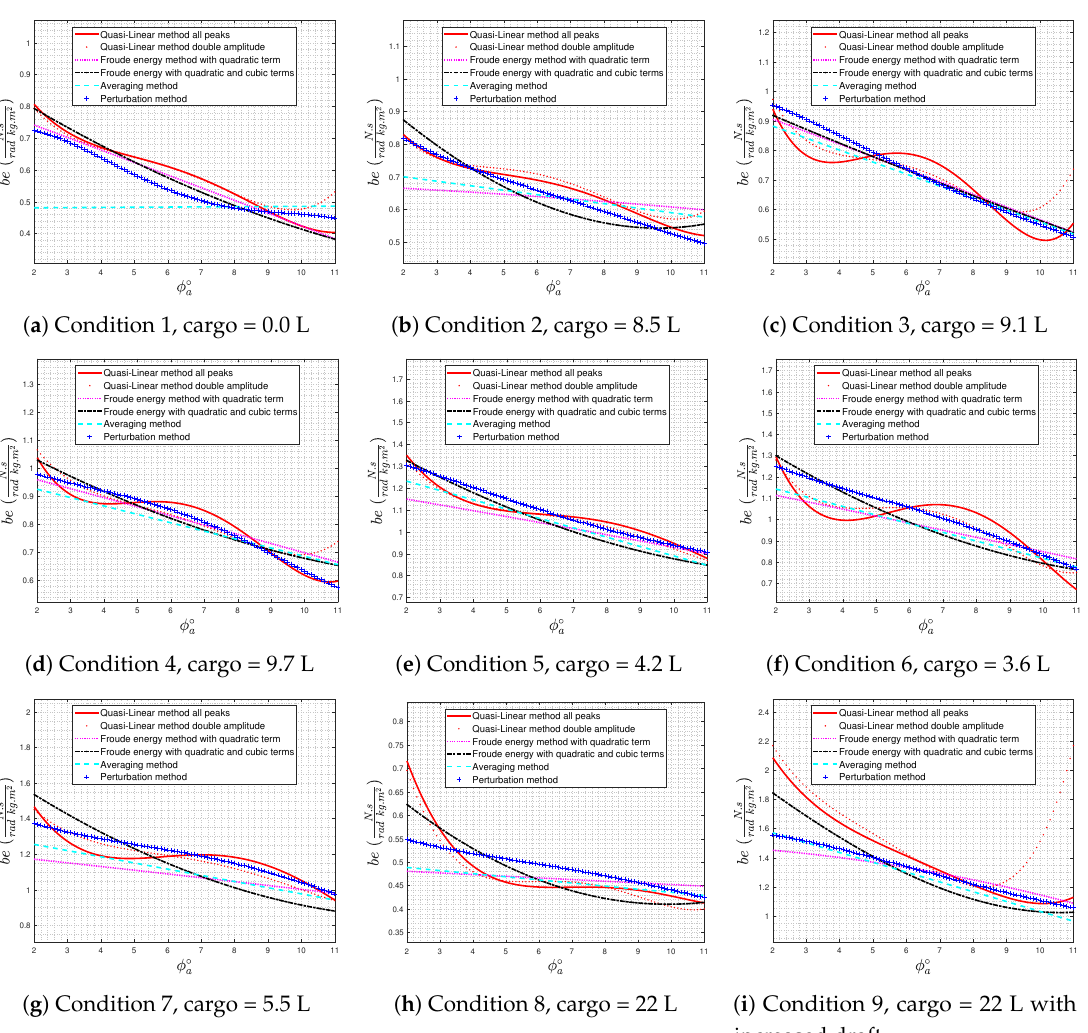
Figure 11. Equivalent linear damping coefficient determined using different analysis methods as a function of roll angle amplitude for different liquid loading